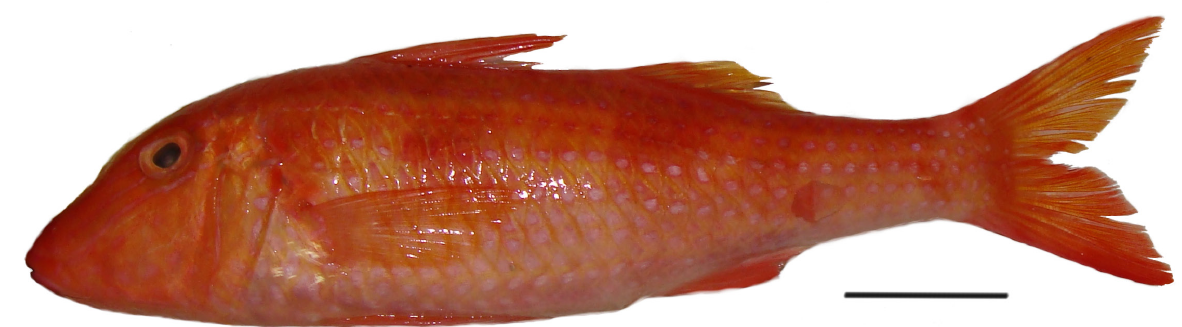
Figure 1 - The host Pseudupeneus maculatus , from the Coast of Pernambuco State, Northeast Brazil. Scale bar: 3